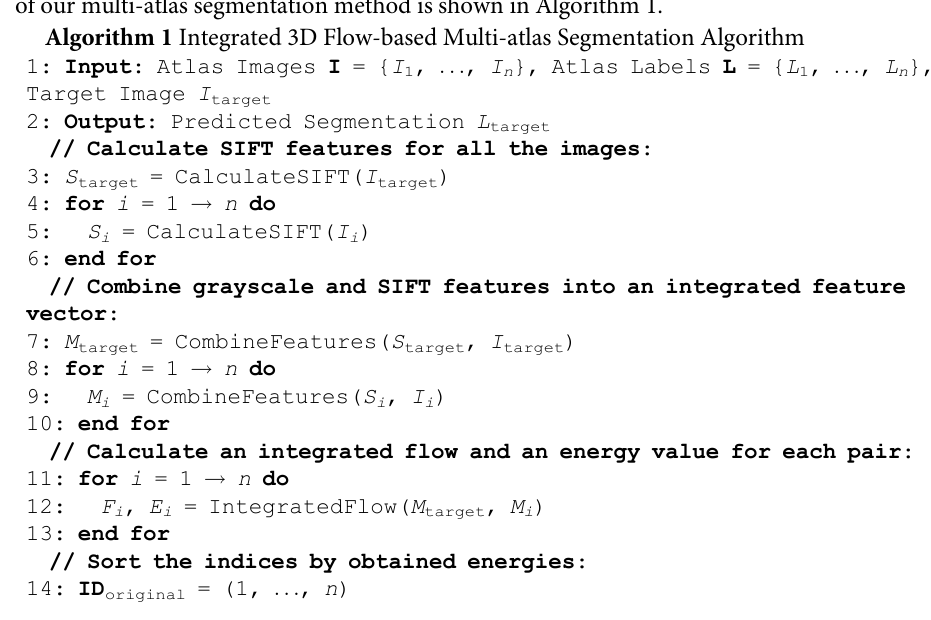
Algorithm 1 Integrated 3D Flow-based Multi-atlas Segmentation Algorithm